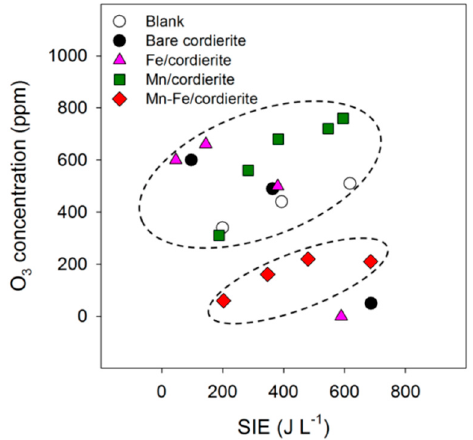
Figure 5. Outlet ozone concentration during decomposition of DEE in one-stage